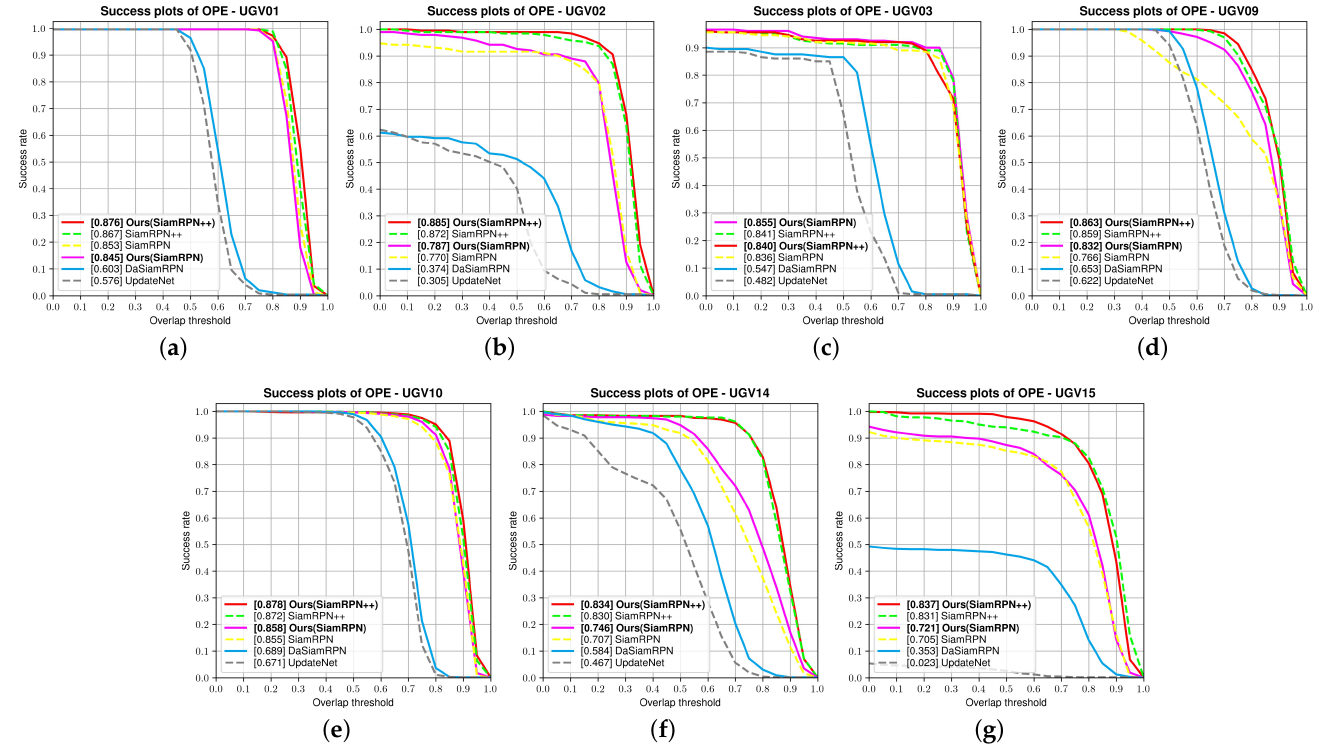
Figure 5. Success plots of the short-term following.